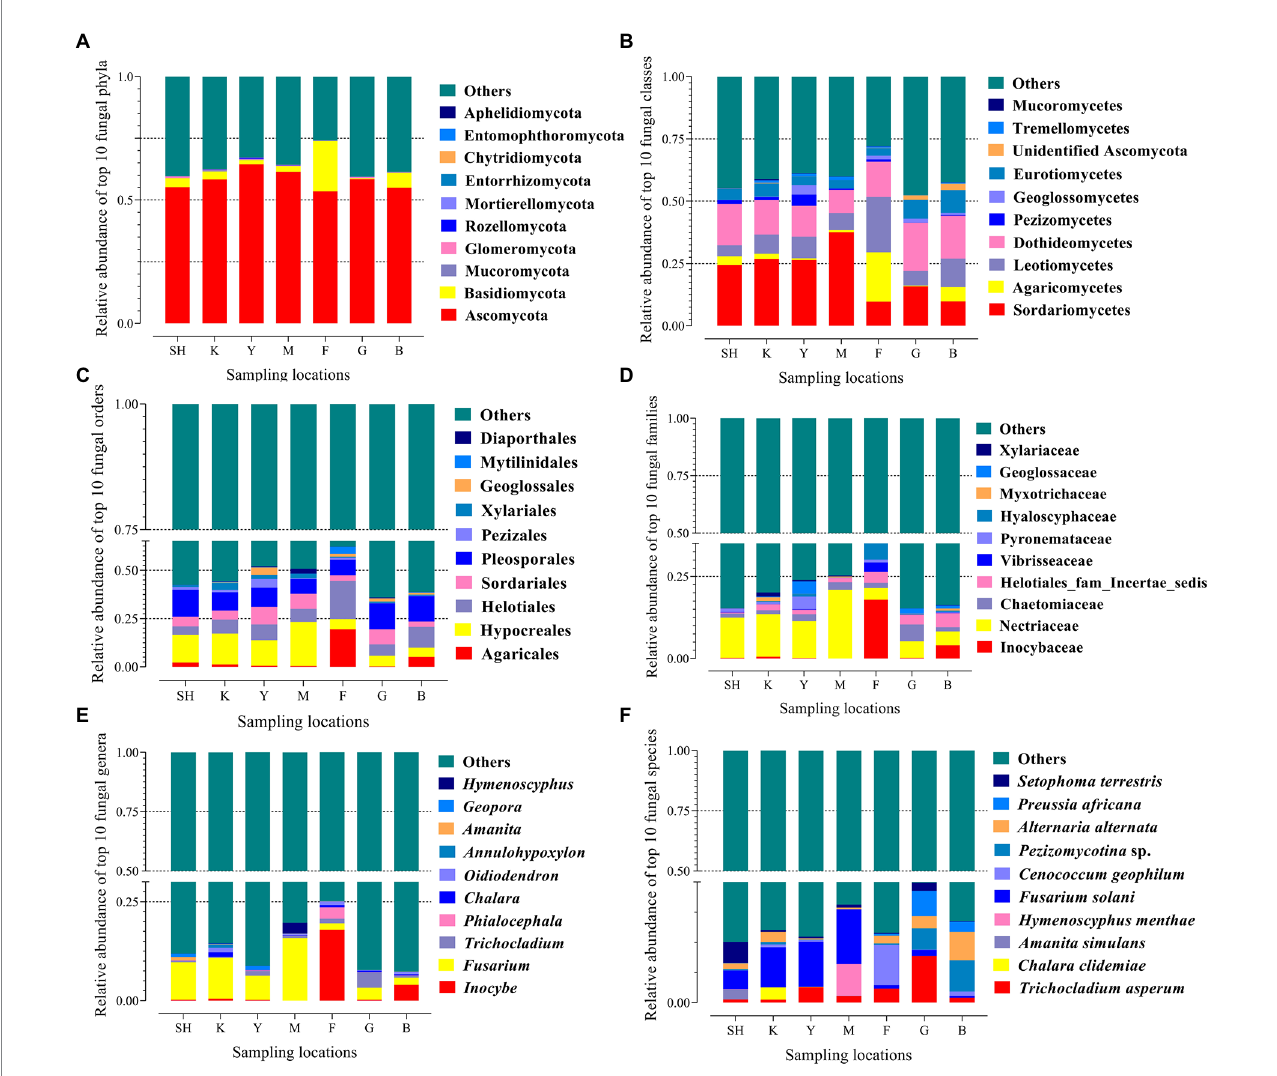
FIGURE 2 Relative abundance of the dominant fungal taxa in seven sampling locations from Sichuan, Hubei, and Hebei Provinces in China. Each bar represents the top ten fungal OTUs at the phylum level (A) , class (B) , order (C) , family (D) , genus (E) , and species (F) ranked by the relative abundance in each sampling location, and different colors represent the frequency of the different OTUs. The designation of ‘other’ indicates that those sequences were not classified into any known group. Abbreviations of variables are given in Figure